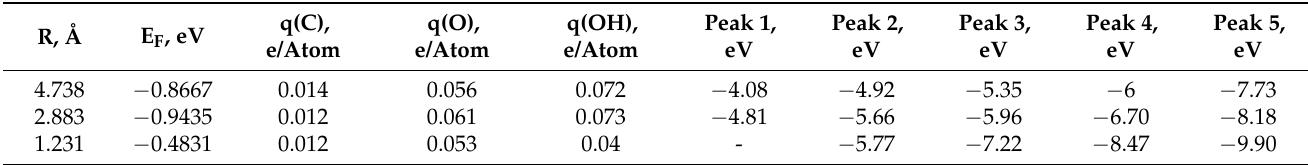
Table 3. Main PDOS parameters of carboxyl components C, O, and